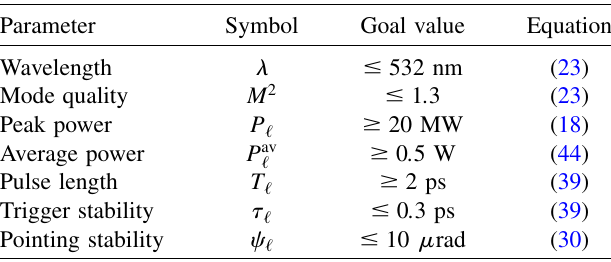
TABLE X. Requirements on laser system for intratrain laser- wire scans at the ILC, with reference to the equation that sets the goal value. Note, an extra factor of 2 has been applied to allow a 50% loss of power due to light transport between the laser and the laser-wire IP, which may involve distances of several hun- dred meters in the